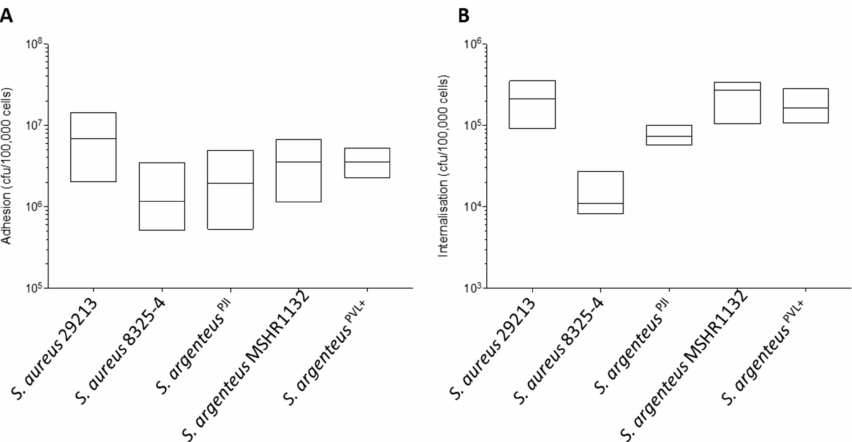
Figure 2. Properties of adhesion and internalization of the S. argenteus PJI strain. ( A ) The adhesion to MG63 cells after 2 h of contact of the S. aureus and S. argenteus strains is expressed in CFU / 100,000 cells. S. argenteus PJI adhere to the cells with a similar e ffi cacy than all the strains tested. ( B ) The intracellular inoculum recovered after 2 h of contact and 1 h of gentamycin treatment to kill the extracellular bacteria is expressed in CFU / 100,000 cells. The S. argenteus PJI responsible for the chronic PJI showed an intermediate internalization between the poorly invasive S. aureus 8325-4 and the invasive S. aureus 29213 or S. argenteus MSHR1132, S. argenteus PVL +